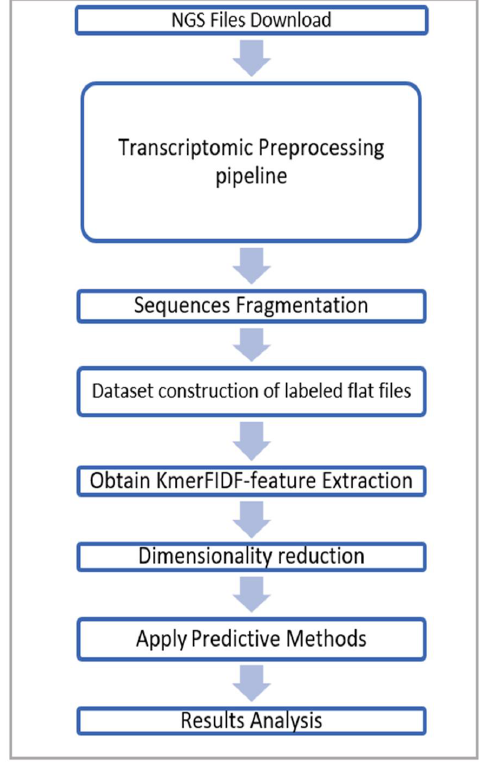
Figure 6. The proposed model using miRNA sequence fragmentation (Model_I).